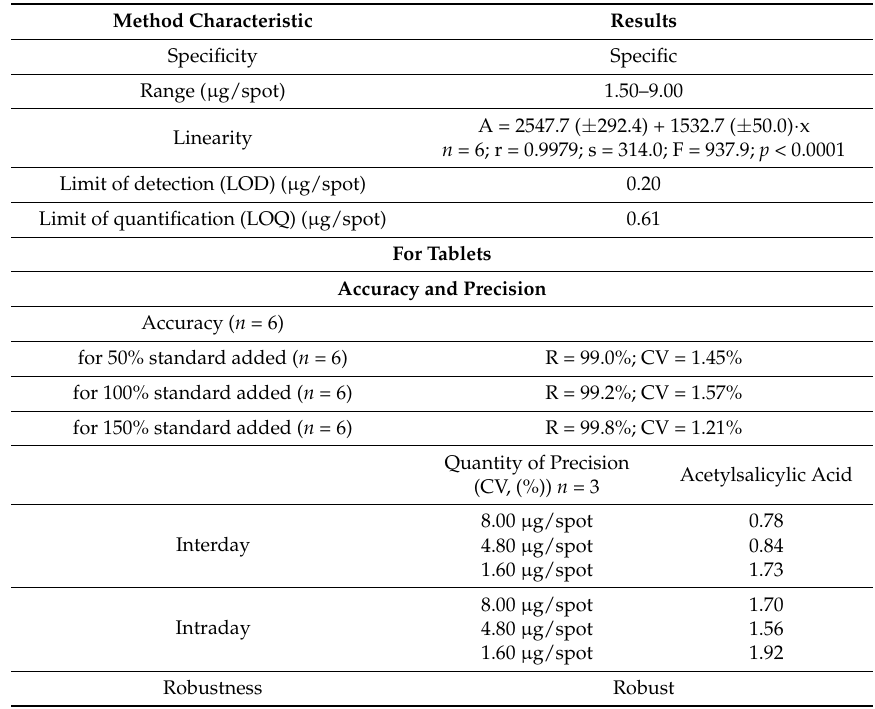
Table 2. The method validation data for the quantitative determination of acetylsalicylic acid by NP-TLC with densitometry a